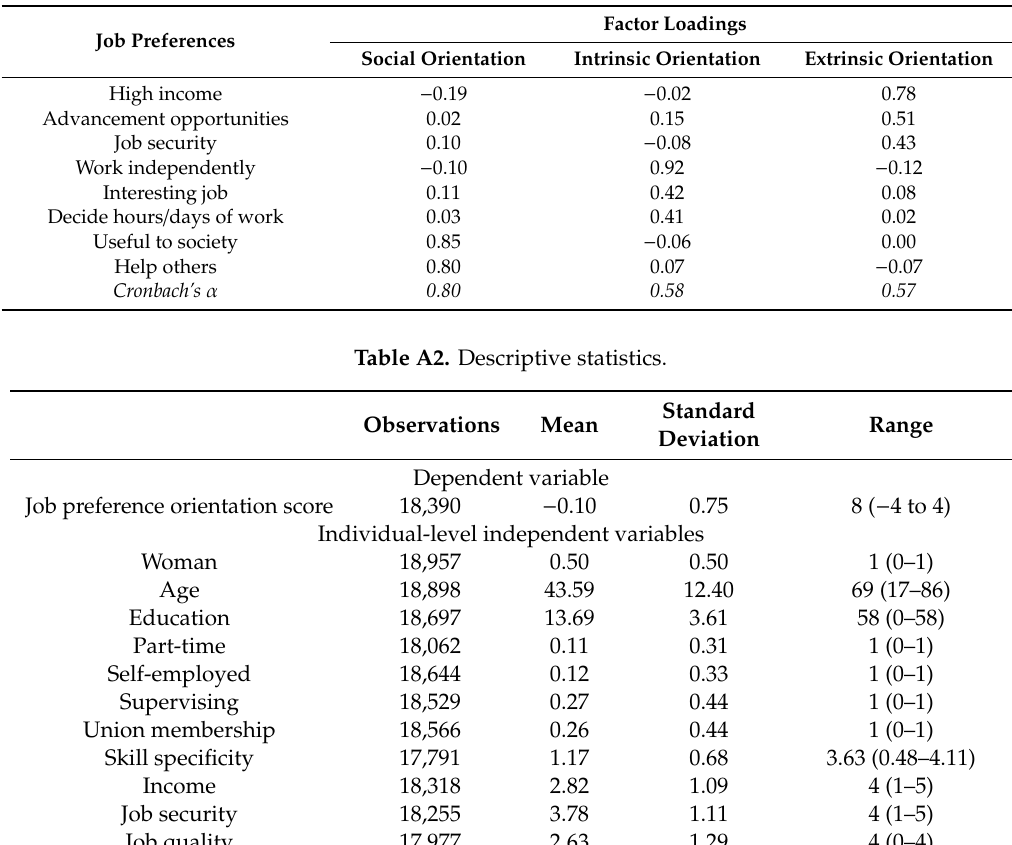
Table A1. Exploratory factor analysis solution (three factors, principal axis factoring, promax rotation).